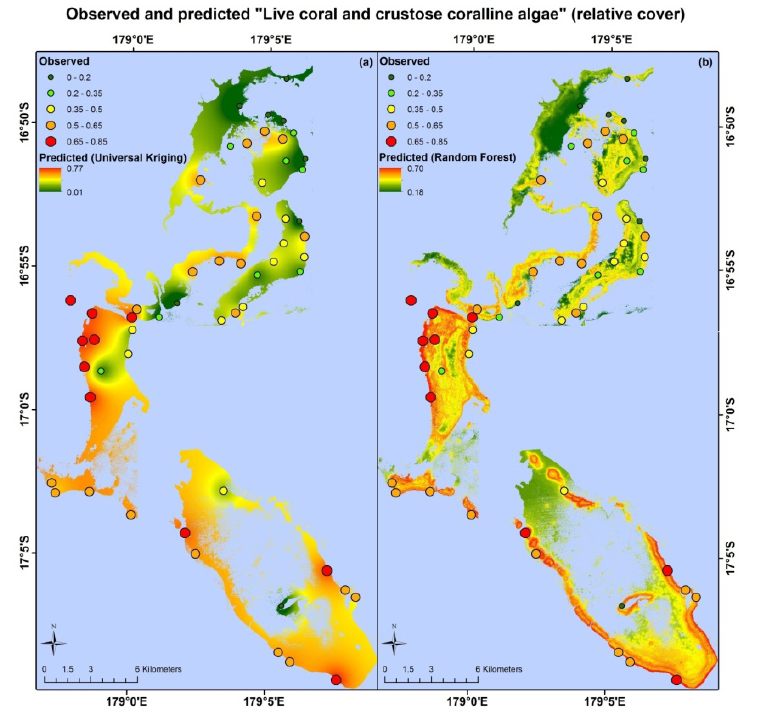
Figure 4. Observed and predicted values of “live coral and crustose coralline algae” for the study area. ( a ) Predictions based on the Universal Kriging model. ( b ) Predictions based on the Random Forest model.